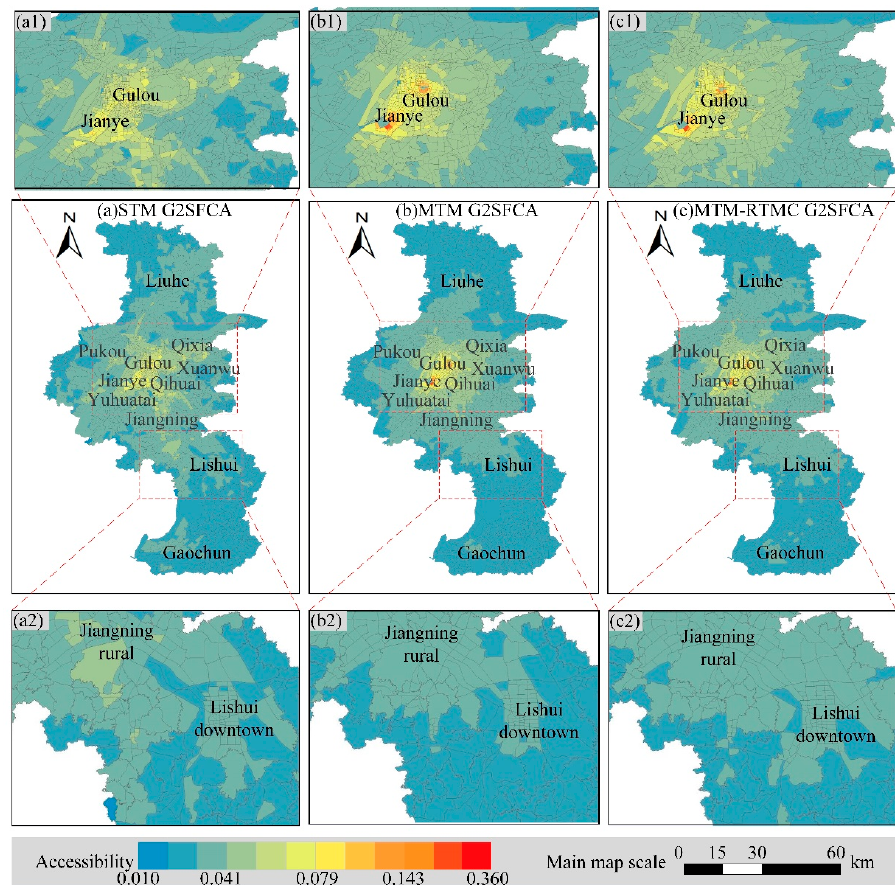
Figure 10. The accessibility results of the three G2SFCA models (STM, MTM, and MTM-RTMC) (high-resolution figure can be seen from https://figshare.com/s/7fc7a00e868a9c71ac37). Table 3. The summary statistics of STM, MTM, and MTM-RTCM G2SFCA models’ results. STM